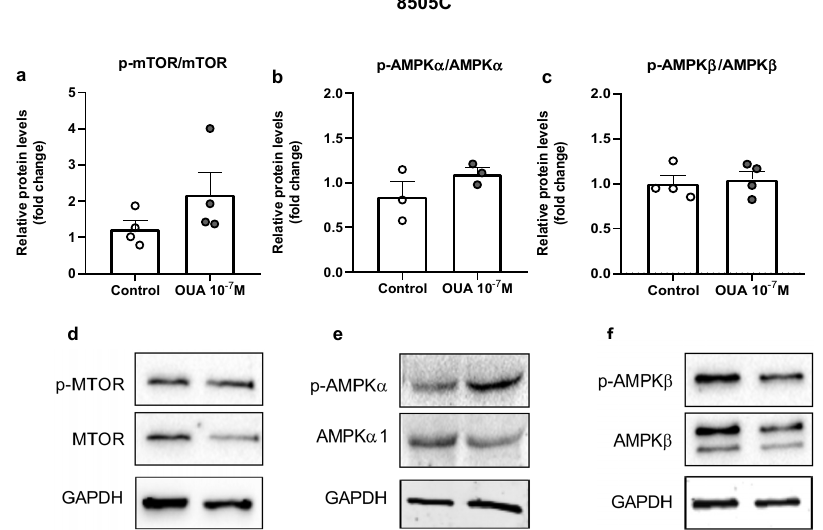
Figure 8. Impact of ouabain on mTOR and AMPK expression in 8505C cells. 8505C cells were cultured in the absence or presence of 10 − 7 M of ouabain and, after 24 h, protein levels of mTOR, p-mTOR, AMPK α 1, p-AMPK α , AMPK β and p-AMPK β were evaluated. ( a – c ) Graphs show relative p-mTOR/mTOR ( a ), p-AMPK α /AMPK α 1 ( b ) and p-AMPK β / AMPK β ( c ) protein levels in control and ouabain-treated 8505C cells. ( d – f ) Representative blots of at least three independent experiments.